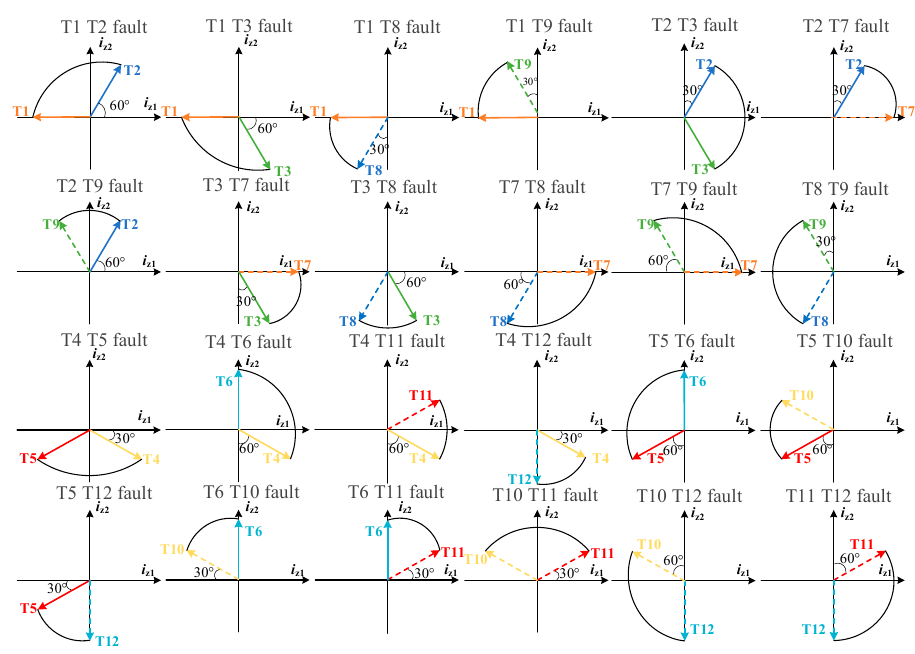
Figure 5. Reference direction of i z1 and i z2 current trace in the case of a single switch failure.